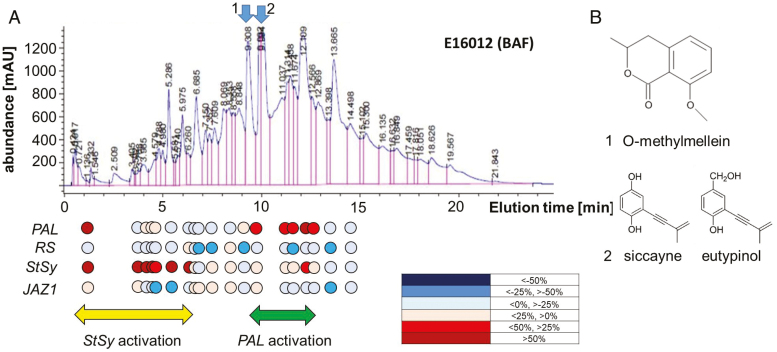
Fractionation of the Eutypa lata IBWF E16012 (BAF) culture filtrate and the effect of fractions on the expression of phytoalexin genes in the cell line V. rupestris GFP–AtTuB6. (A) E16012 (BAF) culture filtrate fractionated by HPLC. The coloured circles show Δ (BAF–PDA): PDA as a percentage showing the stimulation due to medium change and elution time interpolated from the two runs. The cells were treated for 1 h with 20 μl solution of HPLC fractions obtained from the E. lata IBWF E16012 (BAF) and the E. lata IBWF E16012 (PDA) extracts or 0.2% methanol as a mock control; the transcription of genes PAL, RS, StSy, and JAZ1 was measured by semi-qPCR and the semi-qPCR results were quantified by ImageJ. (B) Secondary metabolites identified from E. lata IBWF E16012 extracts: (1) O-methylmelleim; (2) siccayne and eutypinol. The relative induction levels were expressed by using different colours: dark blue: <−50%; blue: <−25%, >−50%; light blue: <0%, >−25%; light red: <25%, >0; red: <50%, >25%; dark red: >50%.